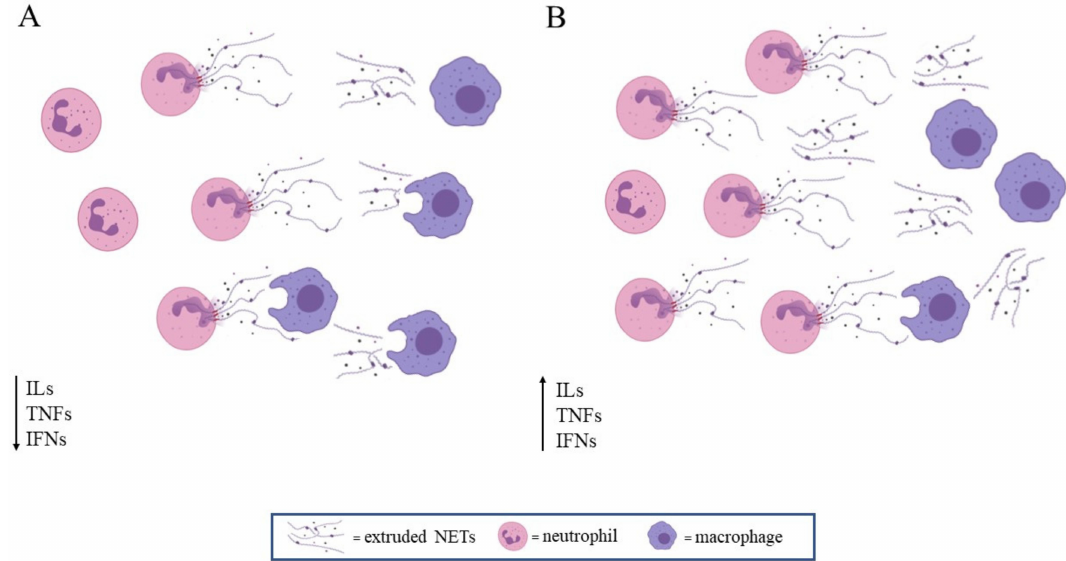
Figure 2. NETosis in physiologic ( A ) and pathologic conditions or ageing ( B ). Interleukins (ILs), tumor necrosis factors (TNFs), and interferones (IFNs). ( A ) NETs extrusion is adequate to the defensive anti-microbial action, and NETs are then removed by macrophages; inflammatory factors drop down. ( B ) Basal or induced NETs extrusion is enhanced, and they are not efficiently removed by macrophages; inflammatory factors increase, leading to long-lasting